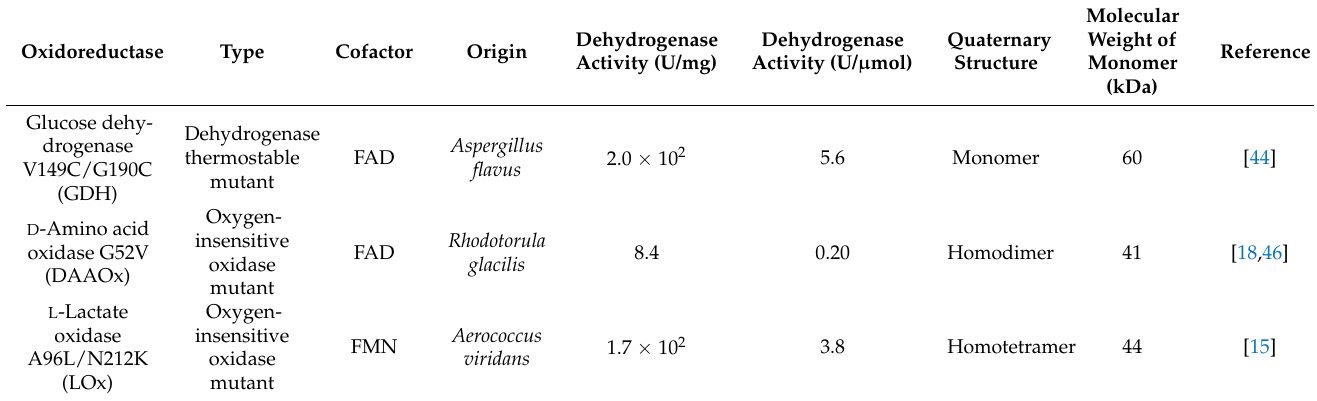
Table 1. Information about flavin-dependent oxidoreductases demonstrated in this research.